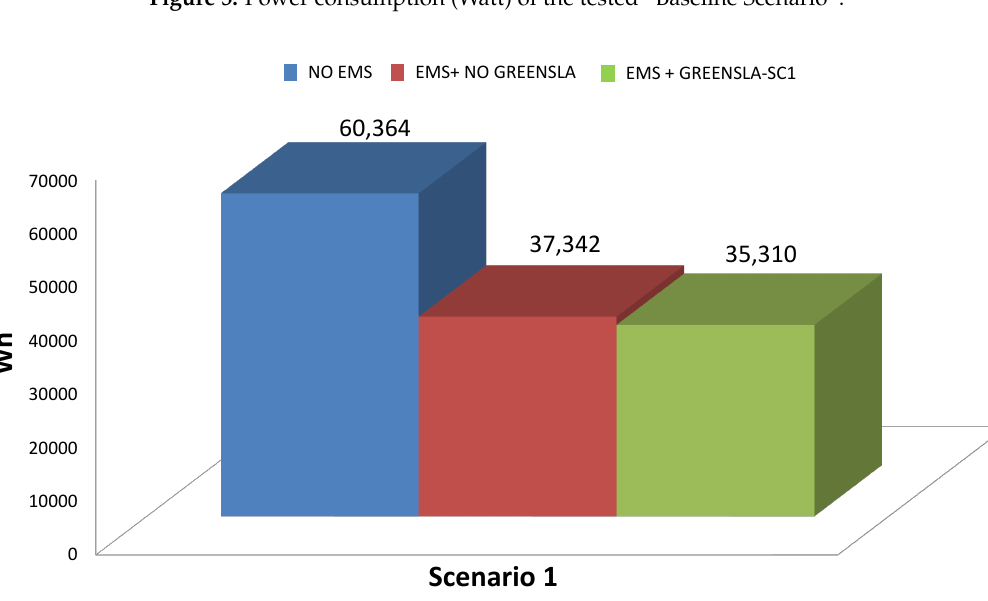
Figure 6. Energy consumption (Wh) of the tested “Baseline